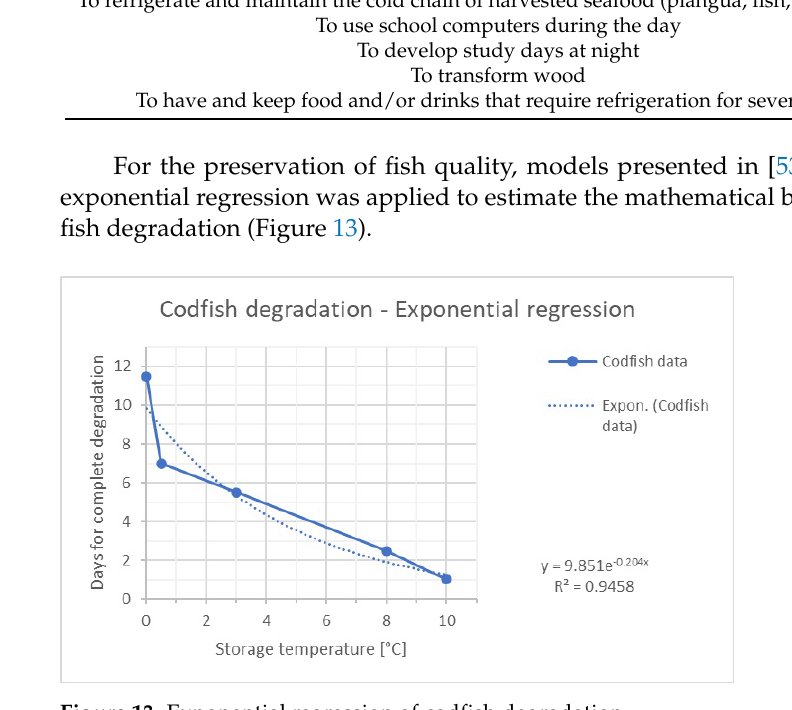
Figure 13. Exponential regression of codfish